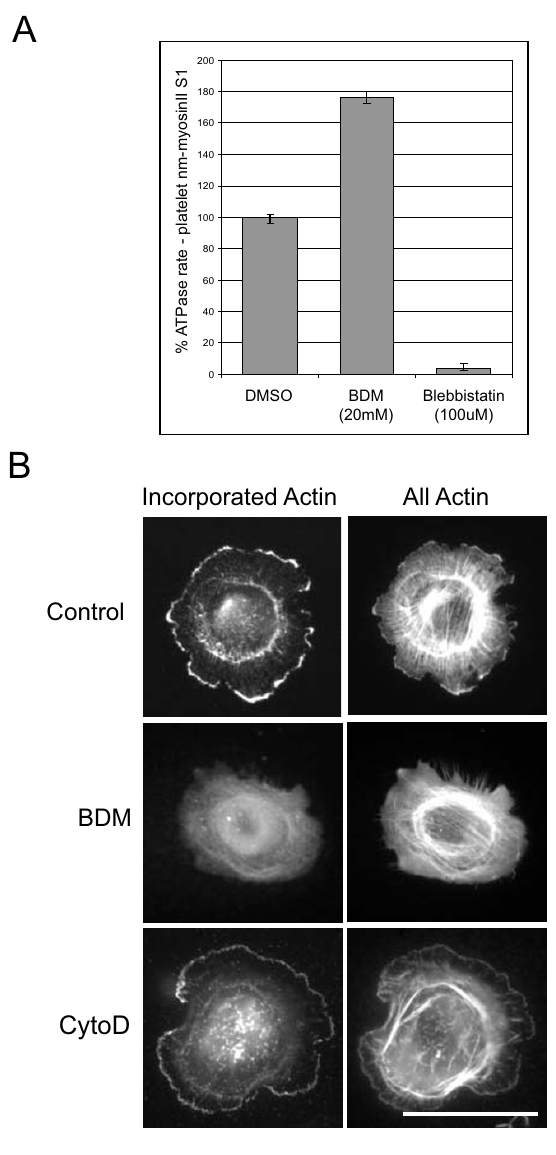
Figure 1 BDM treatment inhibits actin incorpolration in a per- meabilized cell system. (A) BDM does not inhibit platelet myosinII S1 ATPase activity. (B) Spreading Swiss3T3 cells were treated with a media control, BDM, or cytochalasin D for 1 minute prior to permeabilization and incubation with rhodamine-labeled actin. BDM treatment blocks actin incor- poration at the leading edge while control and cyto D treat- ment have no effect. Bar, 50